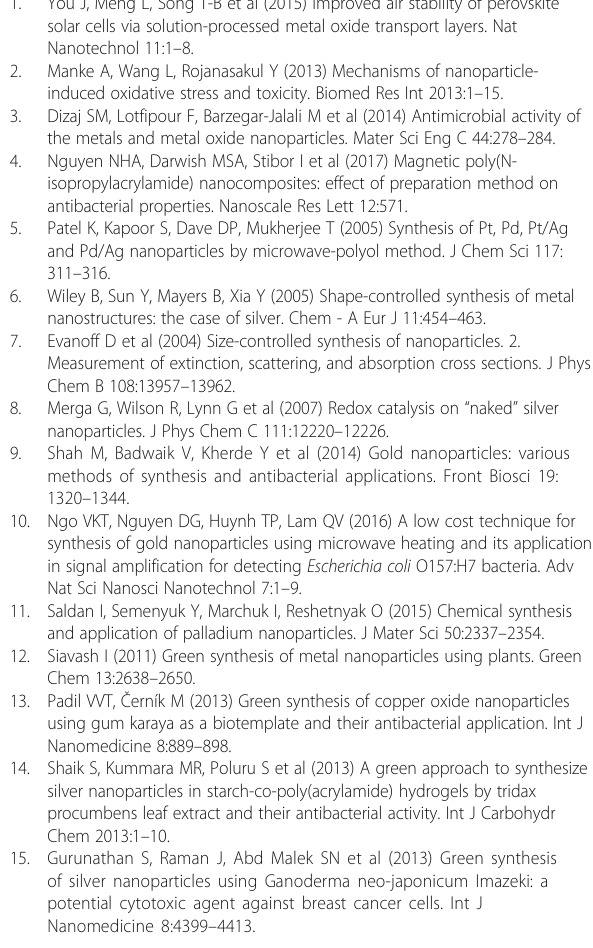
Figure S3. Zeta-potential of NPs after 1 h and 24 h presence in algal growth TAPx4 medium. Figure S4. Abiotic generation of ROS by NPs 1, 3, 5 and 24 h exposure to the different concentrations. Positive control was obtained by incubating the probe with a mixture of 1 mM FeSO 4 and 0.5% H 2 O 2 . The H 2 DCF probe in the exposure medium incubated in the dark was used as a blank control. Data are shown as a ratio between the fluorescent values obtained for the samples and those obtained for the blank control. Error bars represent the standard deviations of triplicate measurements. Dotted lines indicate the background. (DOCX 468